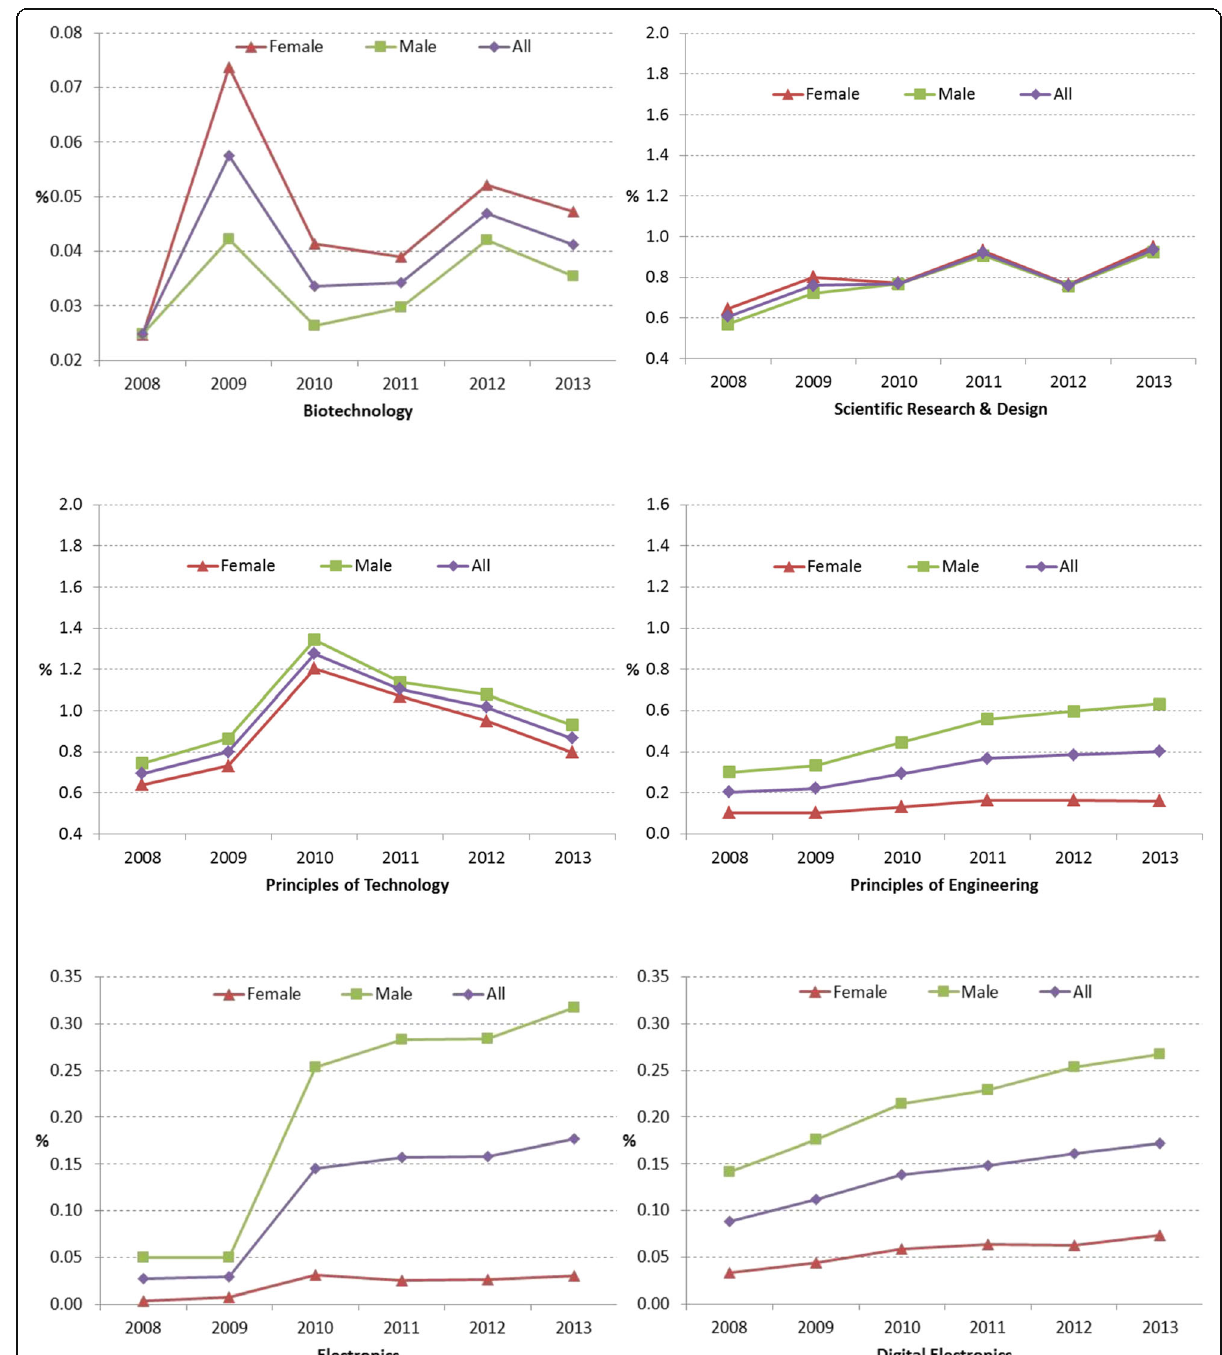
Fig. 5 Six CTE-STEM course enrollment rates in percentage of all female, male, and total number of students from 2008 to